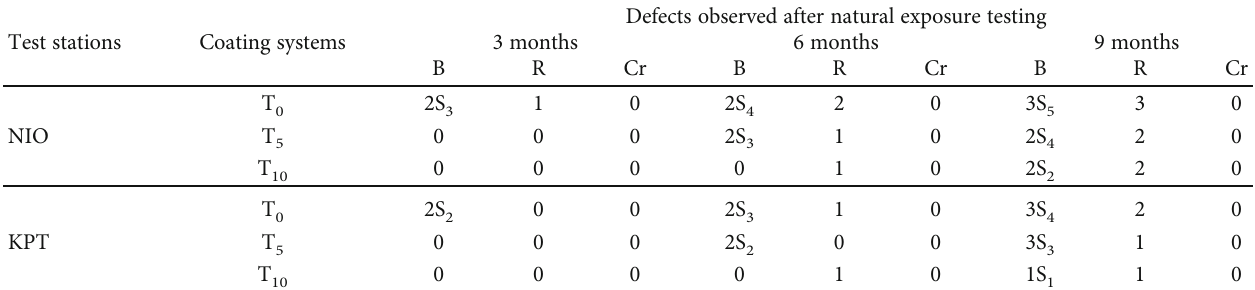
Table 5: Defects rating as per ISO norms 4628 (parts 1-4) in the virgin epoxy coating and titanium-embedded epoxy coatings after natural exposure